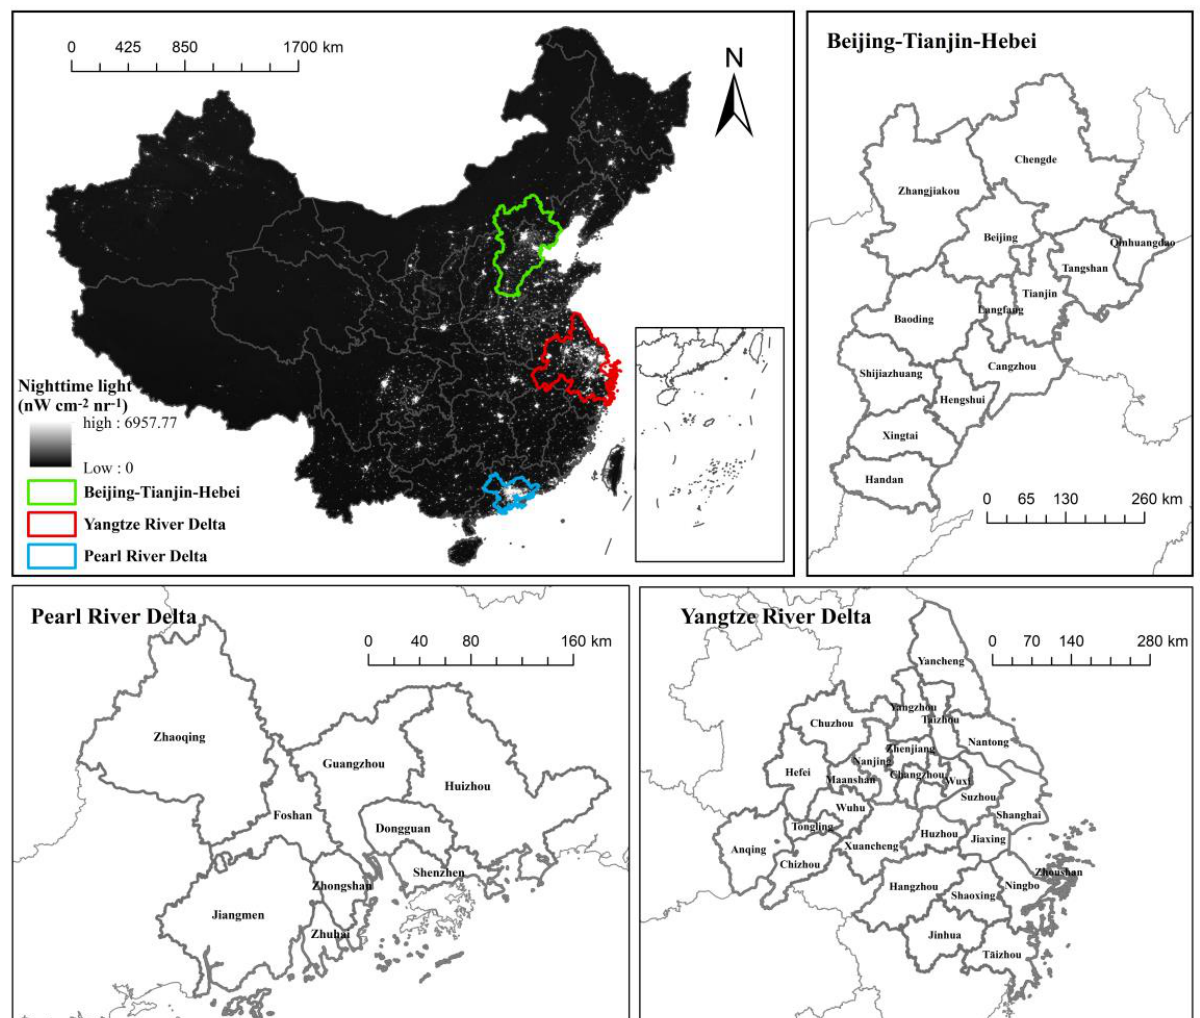
Figure 1. Locations of three urban agglomerations such as Beijing-Tianjin-Hebei Region, Yangtze River Delta, and Pearl River Delta.